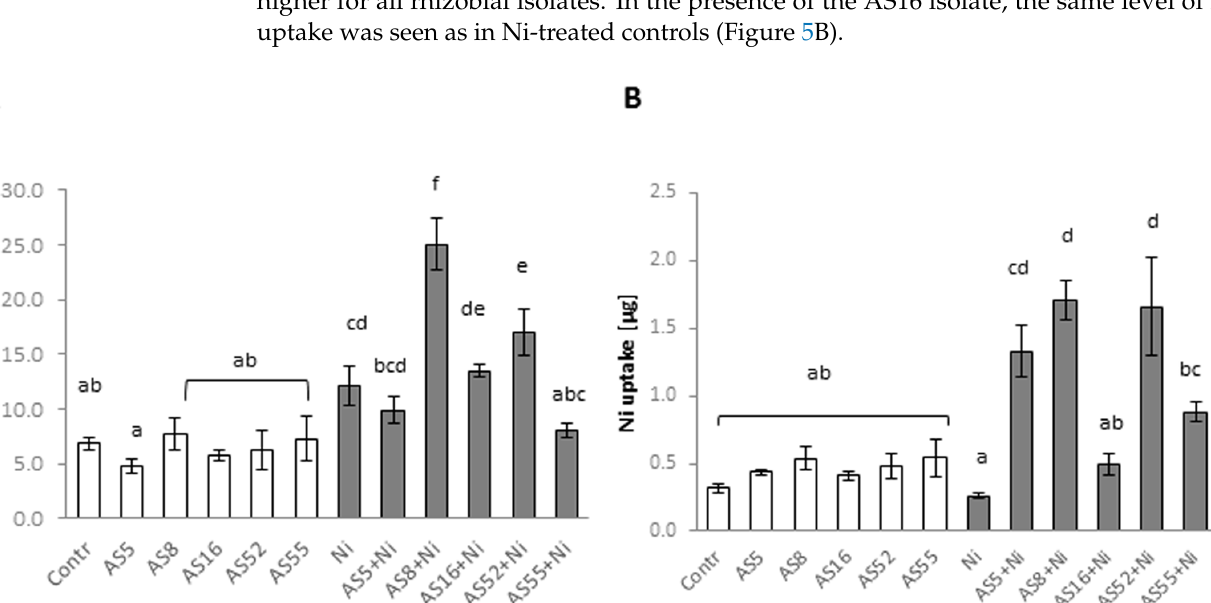
Figure 6. Cross sections of leaves of Arabidopsis non-exposed and exposed to 200 µM Ni, grown under absence or presence of rhizobia. Scale = 50 µm.